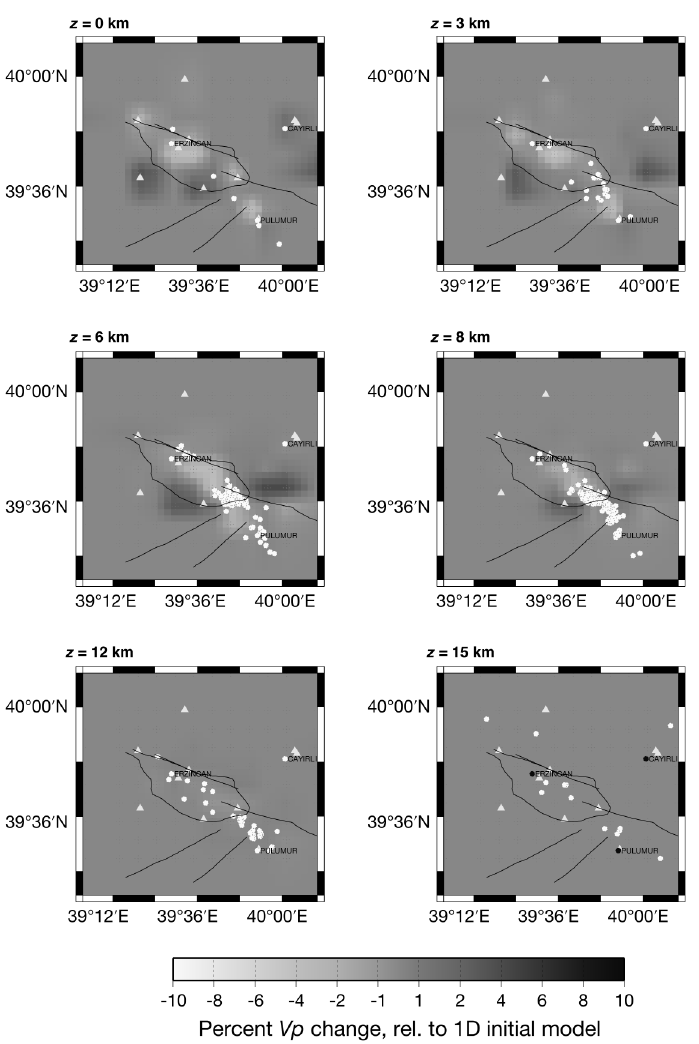
Fig. 11. Horizontal percentage P -wave velocity change relative to the 1D initial model. The grid spacing is 7.5 km in a horizontal